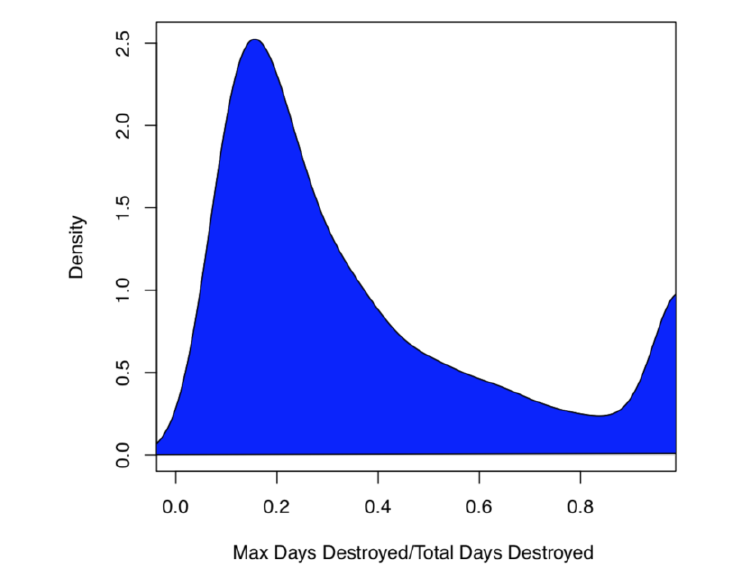
Fig. 4. Proportion of the daily days destroyed that is accounted for by the largest